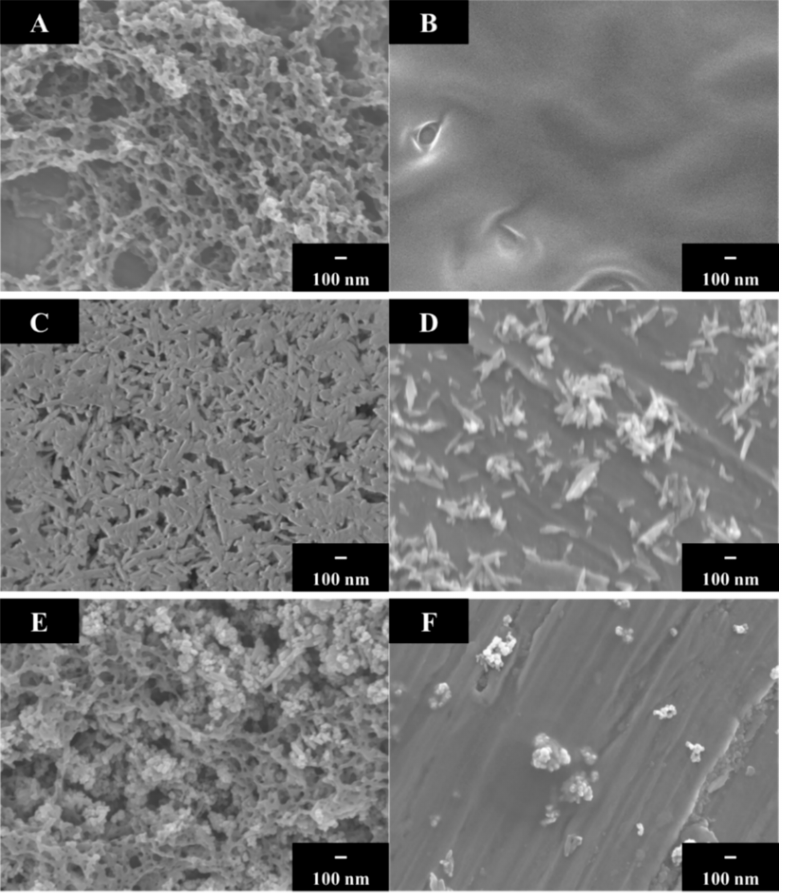
Figure 2. SEM images of ( A , B ) PMMA-Ag 2 O, ( C , D ) PMMA-HAP and PMMA-ZnO coatings, ( A , C , E ) as-deposited and room-temperature-dried, ( B , D , F ) annealed at 200 ◦ C.